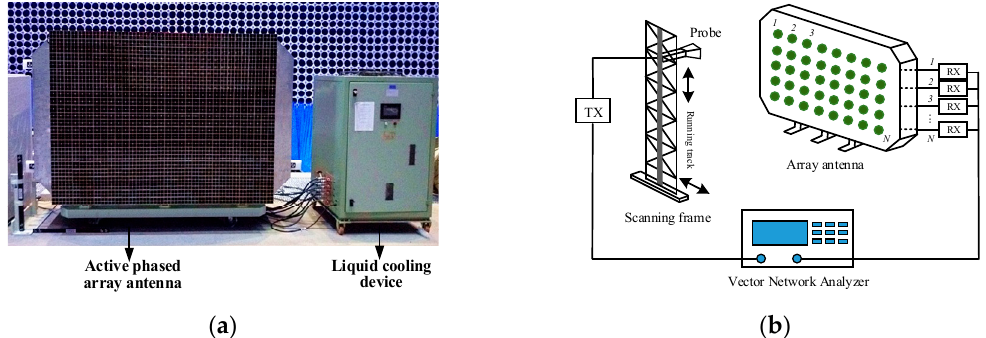
Figure 4. ( a ) APAA and liquid cooling device; ( b ) electromagnetic performance measurement system. The temperature field distribution at 35 °C is taken for illustration; the measured and model-based calculated antenna patterns are shown in Figure 5.